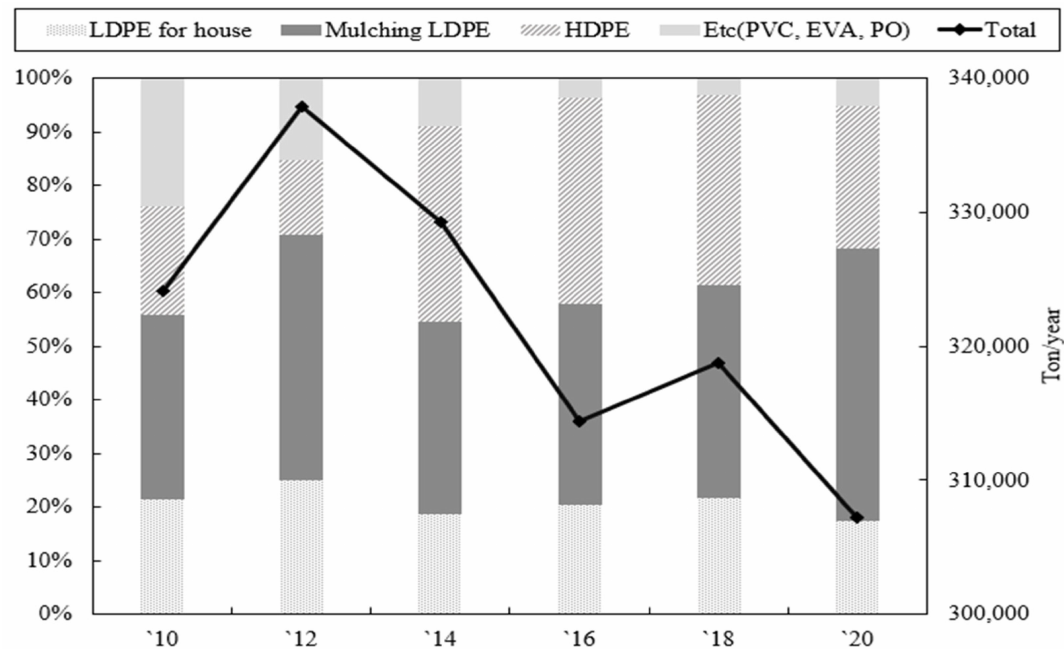
Figure 2. The generation amount of agricultural plastic waste and the generation rate by material [25].